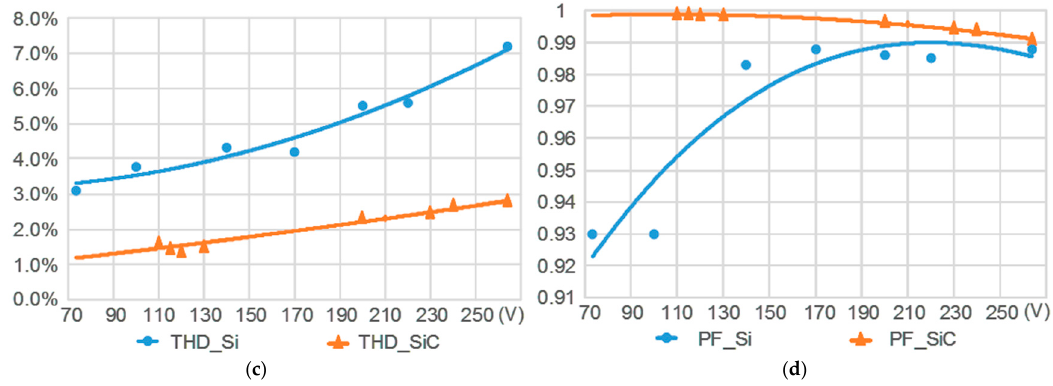
Figure 9. Experimental statistics: ( a ) power factor and efficiency; ( b ) THD, power factor, and efficiency with 100% load; ( c ) THD comparison between Si and SiC devices; ( d ) PF comparison between Si and SiC devices.